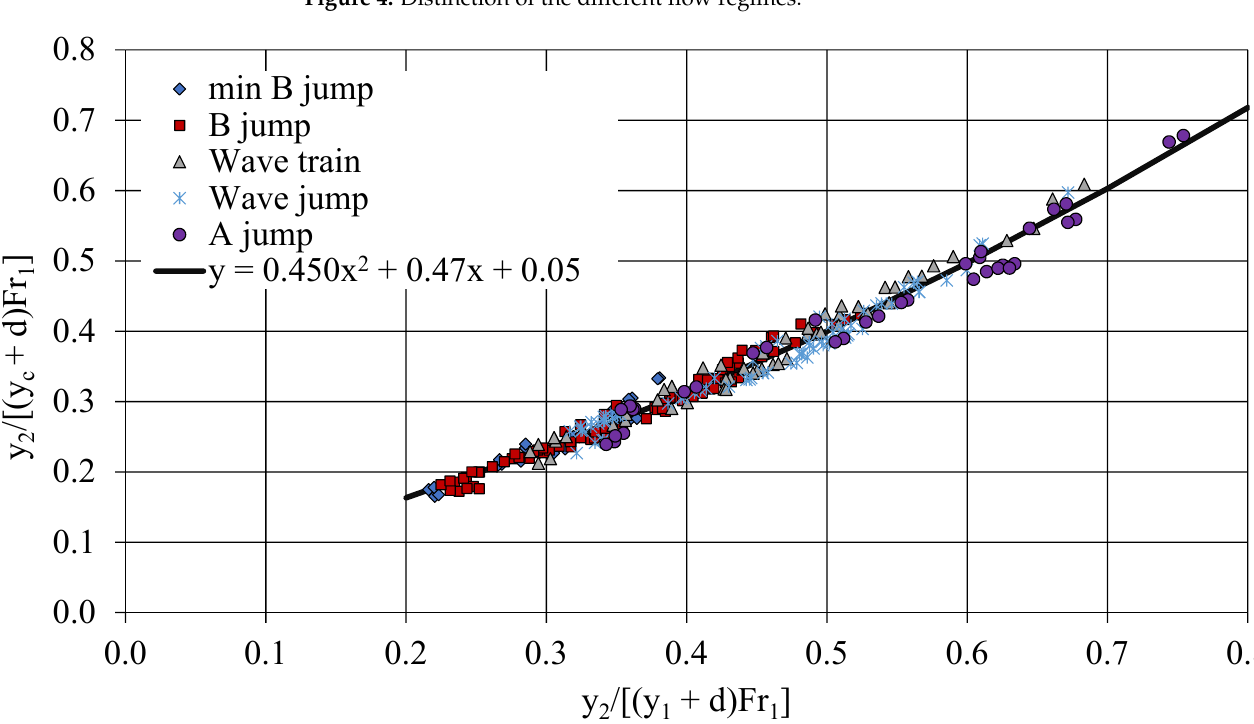
Figure 4. Distinction of the different flow regimes.